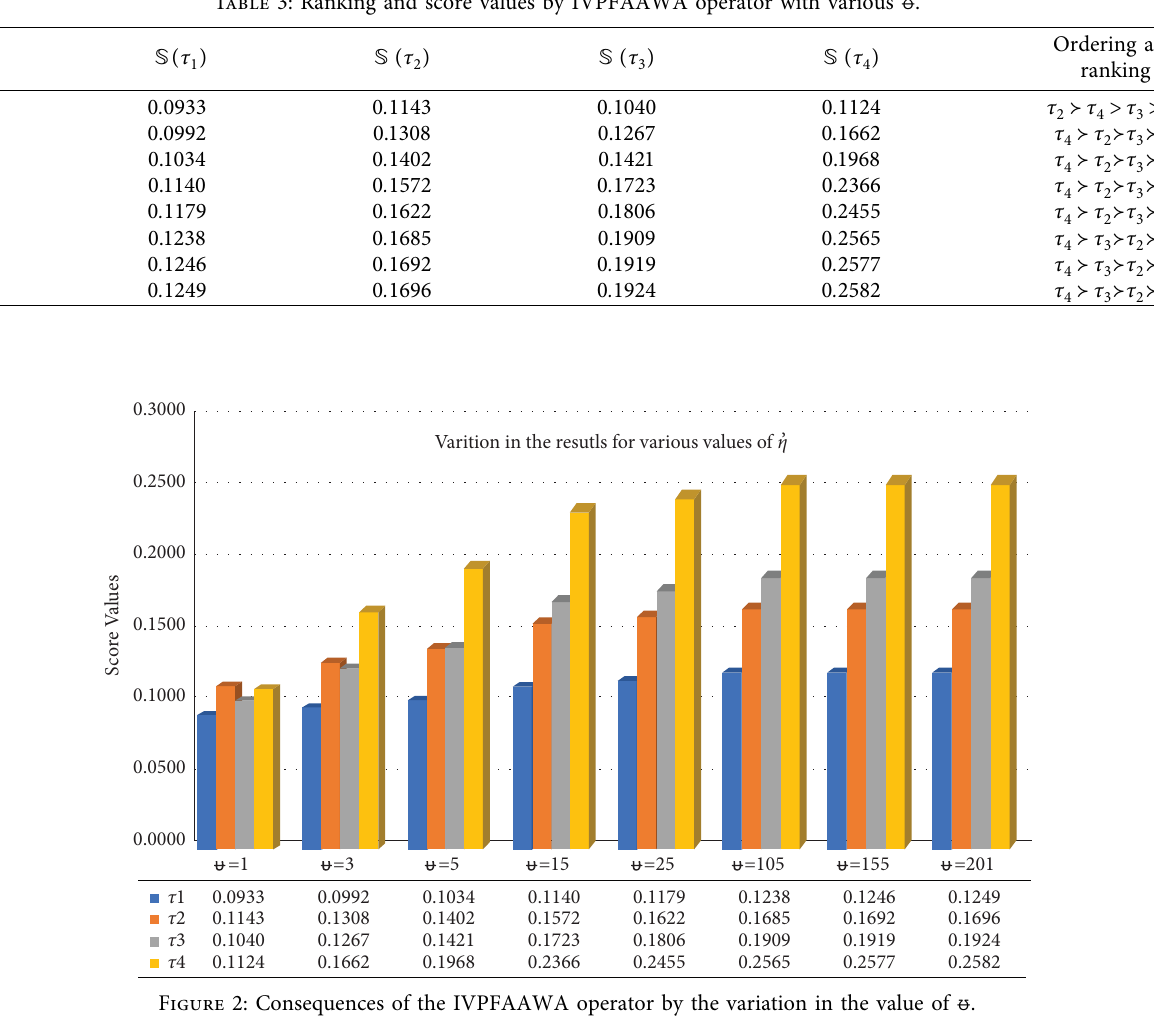
Table 3: Ranking and score values by IVPFAAWA operator with various ᵿ .